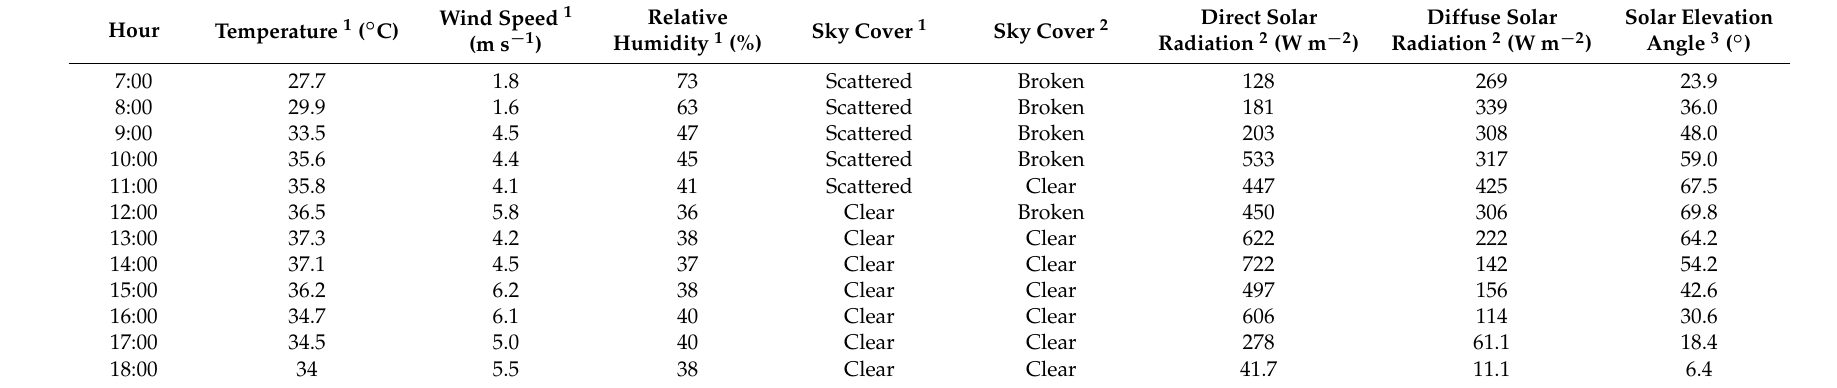
Table 2. Weather measurements at Tokyo Regional Headquarters and Tateno.